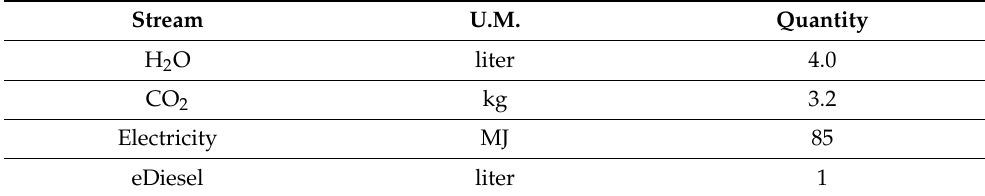
Table A3. Main inputs for eDiesel